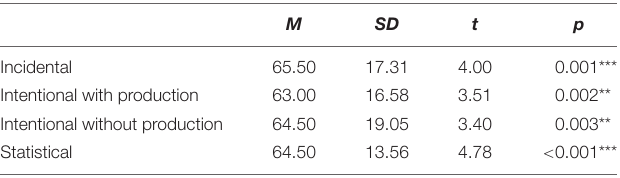
TABLE 2 | t -tests comparing the percentage of word forms learned against a chance level of 50%.